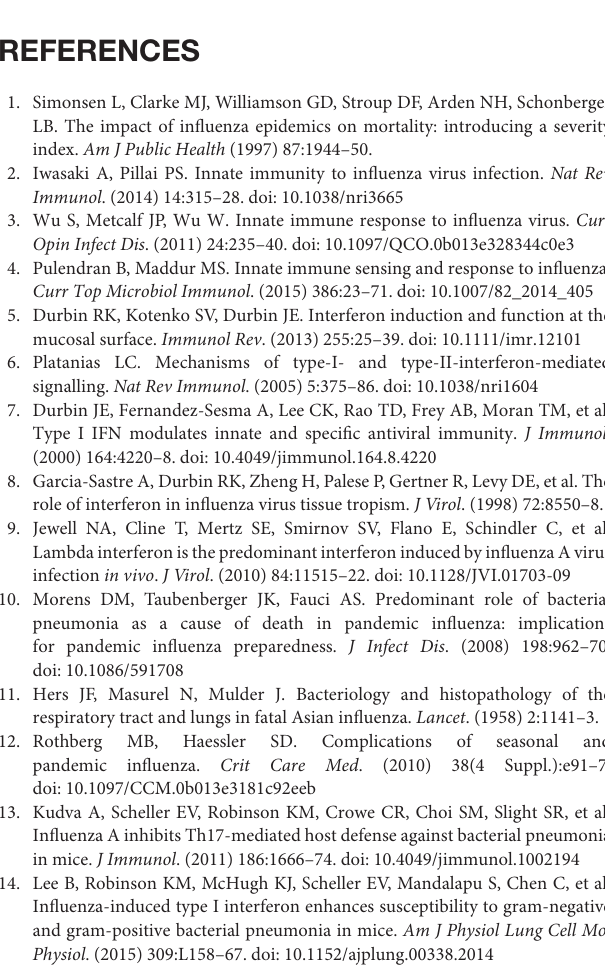
represented as mean ± SEM. Data analyzed using two-tailed Student’s t -test, ns, not significant. FIGURE S2 | Stat2 − / − mice have altered other STAT1 and STA6 signaling pathways during influenza-bacterial super-infection. WT or Stat2 − / − mice were infected with either 100 PFU of influenza A PR/8/H1N1 or influenza for 6 days and then challenged with 5 × 10 7 cfu of MRSA by oropharyngeal aspiration for one additional day, (A) Stat1 , (B) Stat6, (C) Pparg gene expression relative to Hprt was analyzed by RT-PCR. N = 4 per group. Data are represented as mean ± SEM. FIGURE S3 | M1 and M2 macrophages are altered in Stat2 − / − mice in response to Arg1 and IFN γ neutralization during influenza-MRSA super-infection. WT or Stat2 − / − mice were infected with 100 PFU of influenza for 6 days then challenged with 5 × 10 7 cfu of MRSA for one additional day. Mice were treated with 300 µ g of anti-IFN γ antibodies or 300 µ g of rat IgG isotype controls as described in methods. (A) Arg1 + F4/80 + producing cells, were determined by IHC, N = 4–13 per group. WT or Stat2 − / − mice were infected with 100 PFU of influenza for 6 days then challenged with 5 × 10 7 cfu of MRSA for one additional day. Mice were treated with Vehicle (DMSO) or N-hydroxy-nor-L-arginine (nor-NOHA) as described in methods. (B) iNOS + F4/80 + cells, N = 6–9 per group. Data are represented as